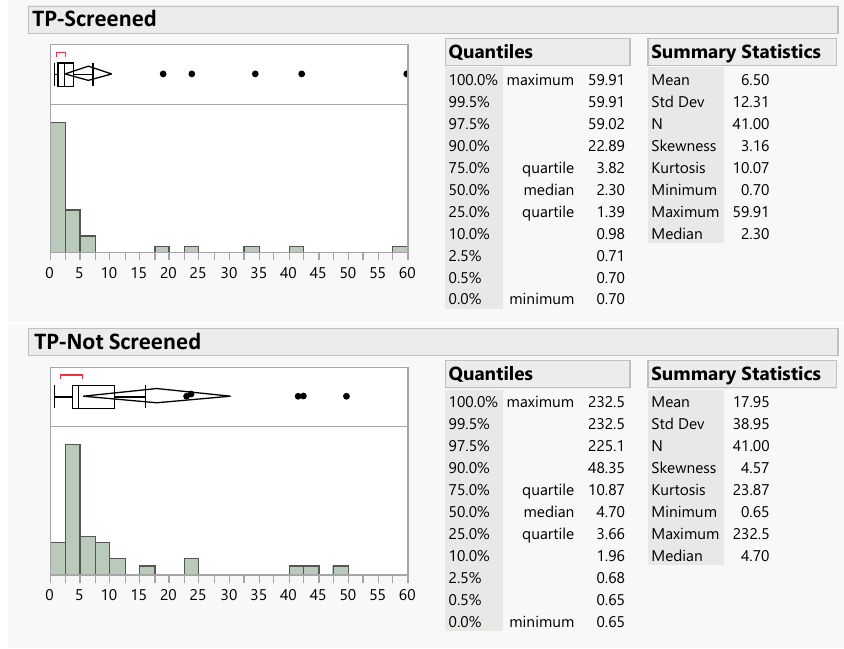
Figure 11. Distributions and summary statistics for the screened and unscreened TP samples collected side by side. The x -axis does not include the full range of the data to better show detail in the lower range. Data units are mg/m 2 /week.